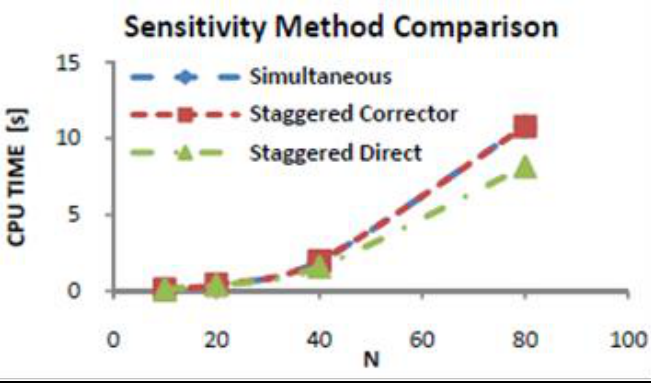
Figure 14: Comparison of the CPU time for the numerical sensitivity methods.